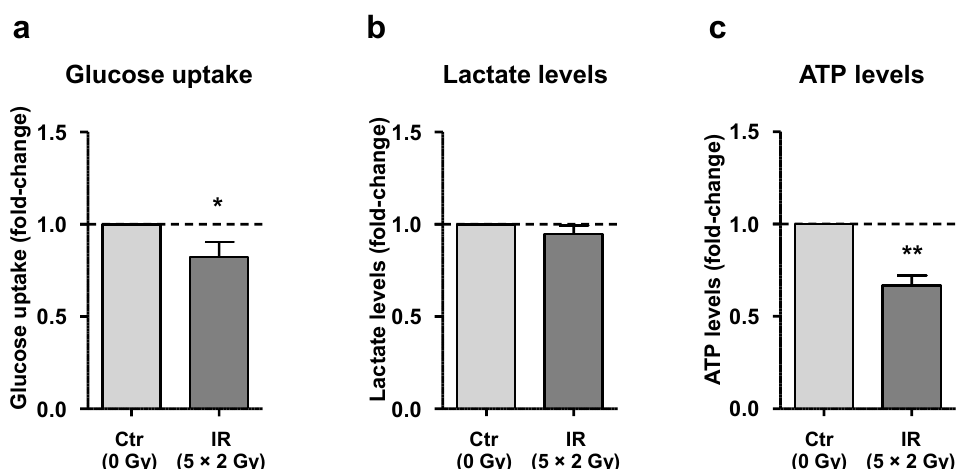
Figure 3. IR affects macrophage metabolism by promoting a reduction of both glucose uptake and total cellular ATP levels. ( a , b ) Both glucose ( n = 12) and lactate ( n = 14) levels were determined in conditioned medium (CM) of irradiated (IR, 5 × 2 Gy) and non-irradiated (Ctr, 0 Gy) macrophages. To estimate glucose uptake, glucose levels were subtracted to the initial glucose concentration of RPMI medium. ( c ) ATP was measured in irradiated (IR, 5 × 2 Gy) and non-irradiated (Ctr, 0 Gy) macrophages after cell lysis ( n = 6). Data are represented as the mean ± SEM (* p < 0.05 and ** p < 0.01). A one sample t -test was used for statistical analysis.